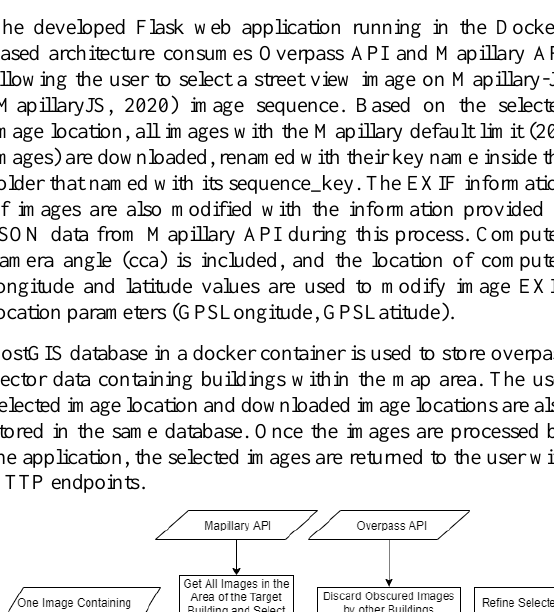
Figure 3. The basic user interface of the flask web application